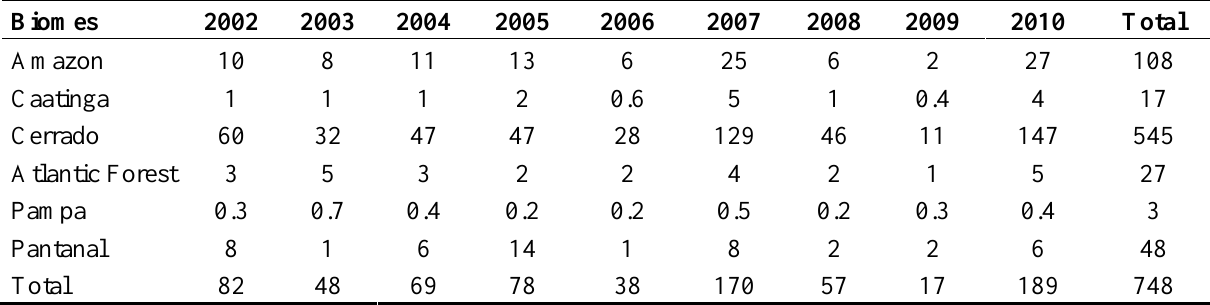
Table 1. Annual extension of the total burned area (in 1,000 km 2 ) in the Brazilian territory (biomes) for the 2002–2010 period.